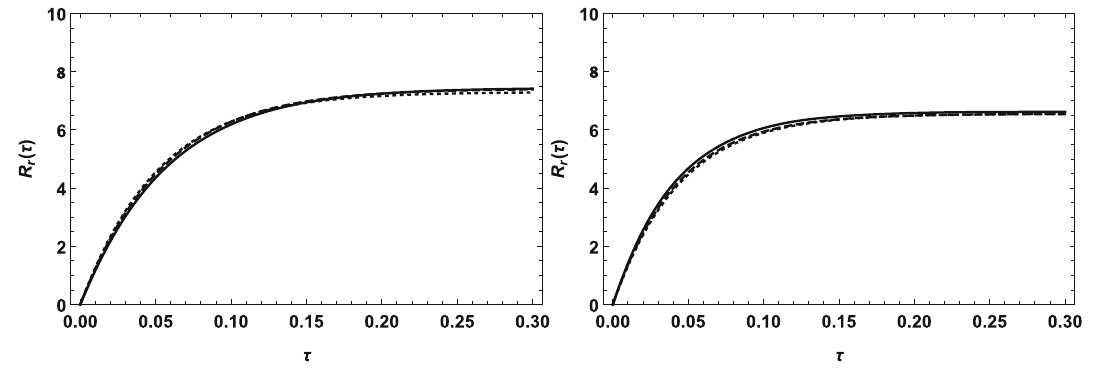
ϕ 2 + ς ϕ 4 and right plot is 2 4